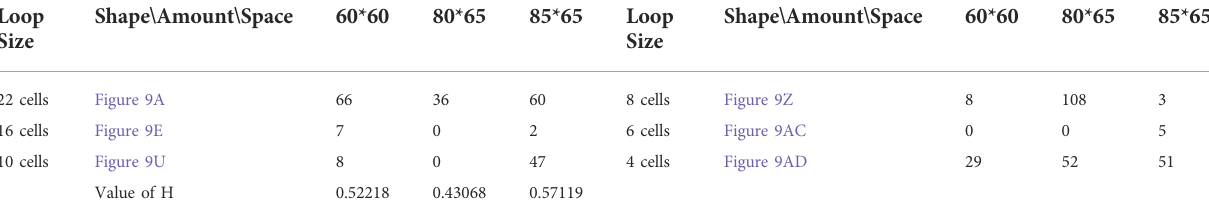
TABLE 5 Statistical numbers of the loops with various structures for the greedy selection mechanism on different cellular spaces starting from the initial con fi guration in Figure 7B. Loop Size